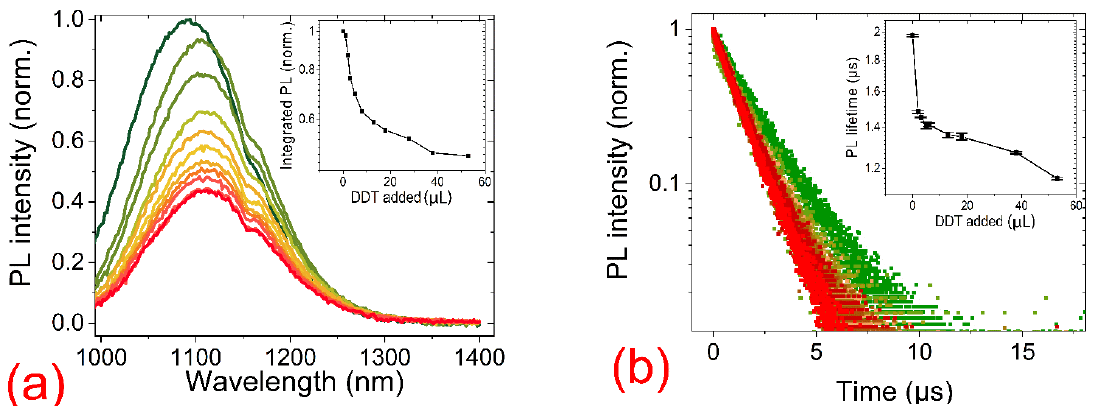
Figure 3. ( a ) PL decay curves for PbS QD solution with different amounts of added DDT (from green = 0 DDT to red = 53 µL DDT). Inset—average PL lifetimes of the QD solution plotted vs. amount of added DDT; ( b ) PL spectra for the QD solution with different amounts of added DDT (from green = 0 DDT to red = 53 µL DDT). Inset—integrated PL intensity plotted vs. amount of added DDT.